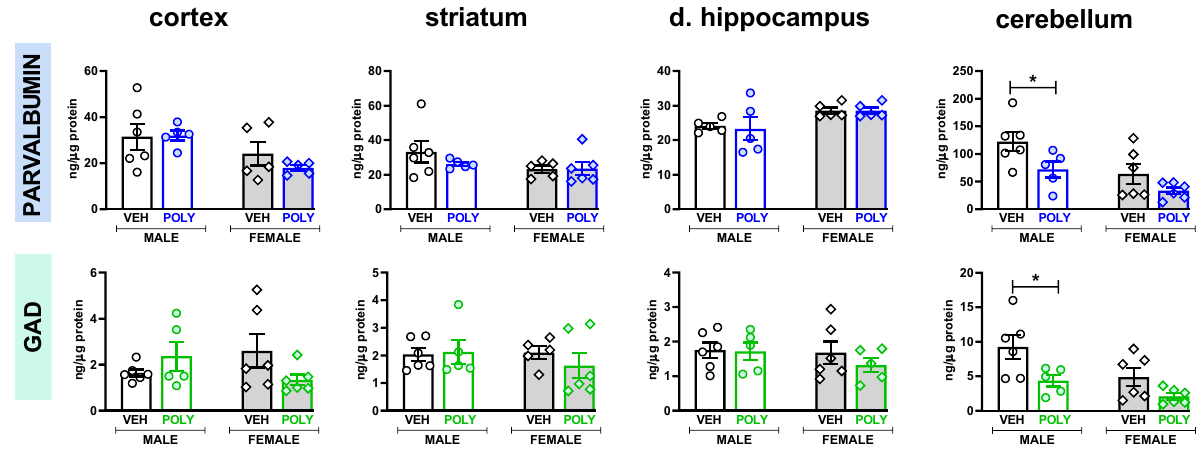
Figure 10. Protein levels of parvalbumin and GAD67. Poly(I:C) exposure decreased the expression of parvalbumin and GAD67 in the cerebellum. *p < 0.05, a significant difference between vehicle- and poly(I:C)- exposed males (planned